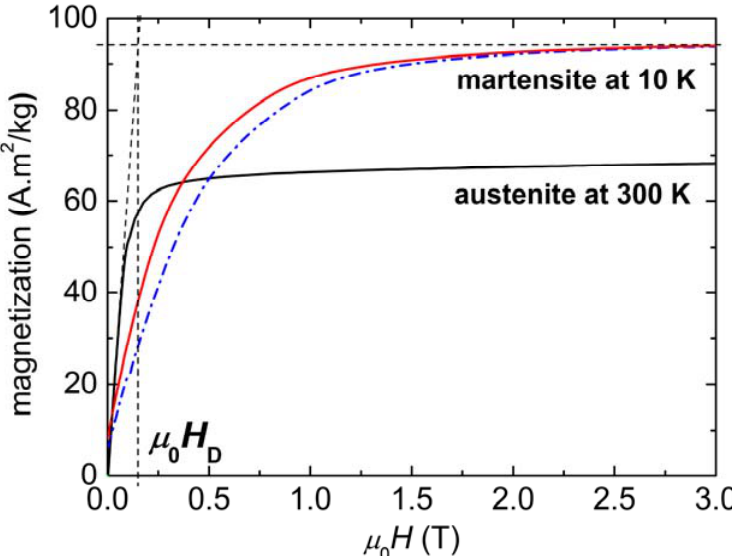
Figure 1. Measured magnetization loops of austenite (black) and martensite (dashed blue) measured at 300 K and 10 K, respectively. Demagnetization field μ 0 H D at M s of martensite determined from the initial slope of the austenite loop is shown. Work done by internal magnetic field, equal to anisotropy energy, is given by the area above the magnetization curve corrected for demagnetization (red).